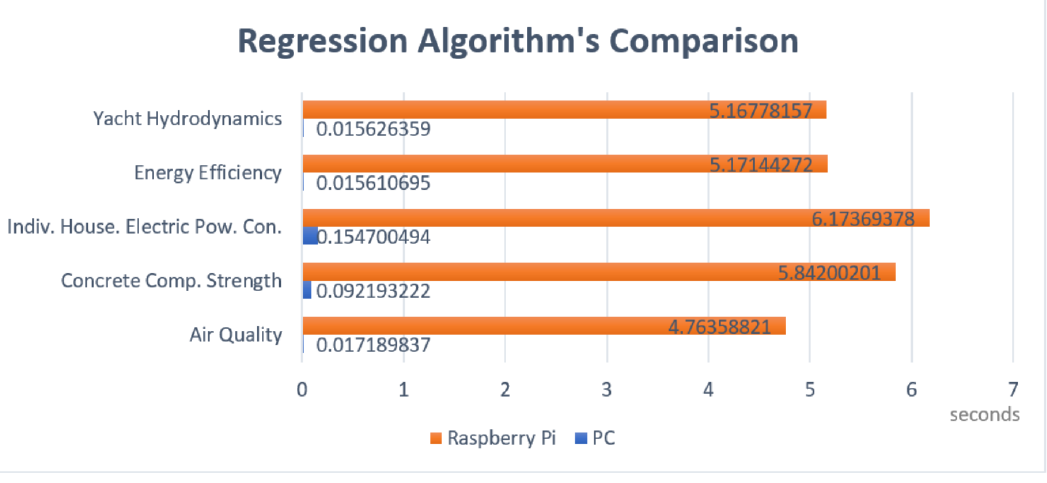
Figure 6. Random Forest-Execution Time-Raspberry Pi vs. PC.